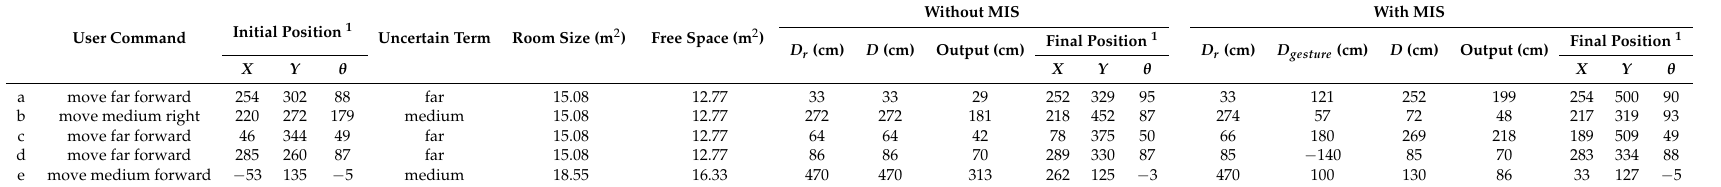
Table 2. Sample results of the experiment for validating the behaviors of the motion intention switcher